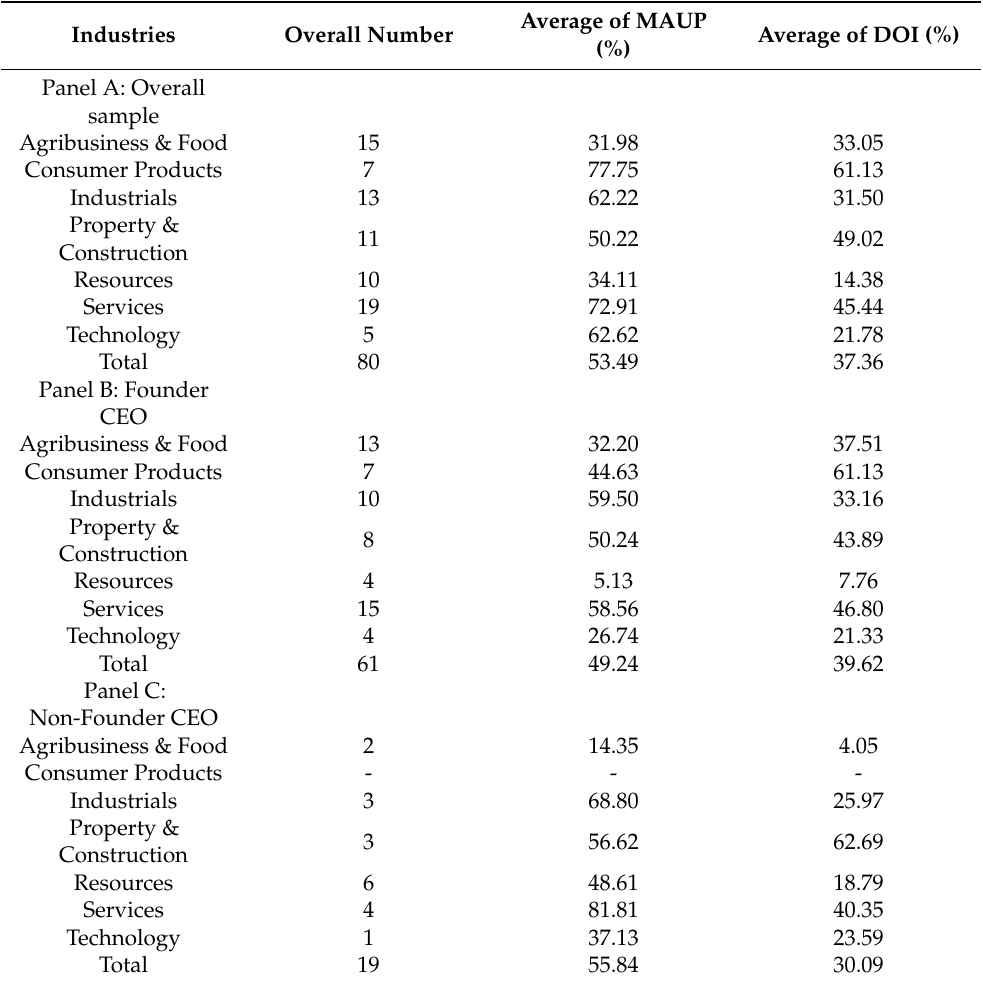
Table 5. Number of IPOs by industry, MAUP, and DOI for the full sample, samples of founder CEO and non-founder CEO.